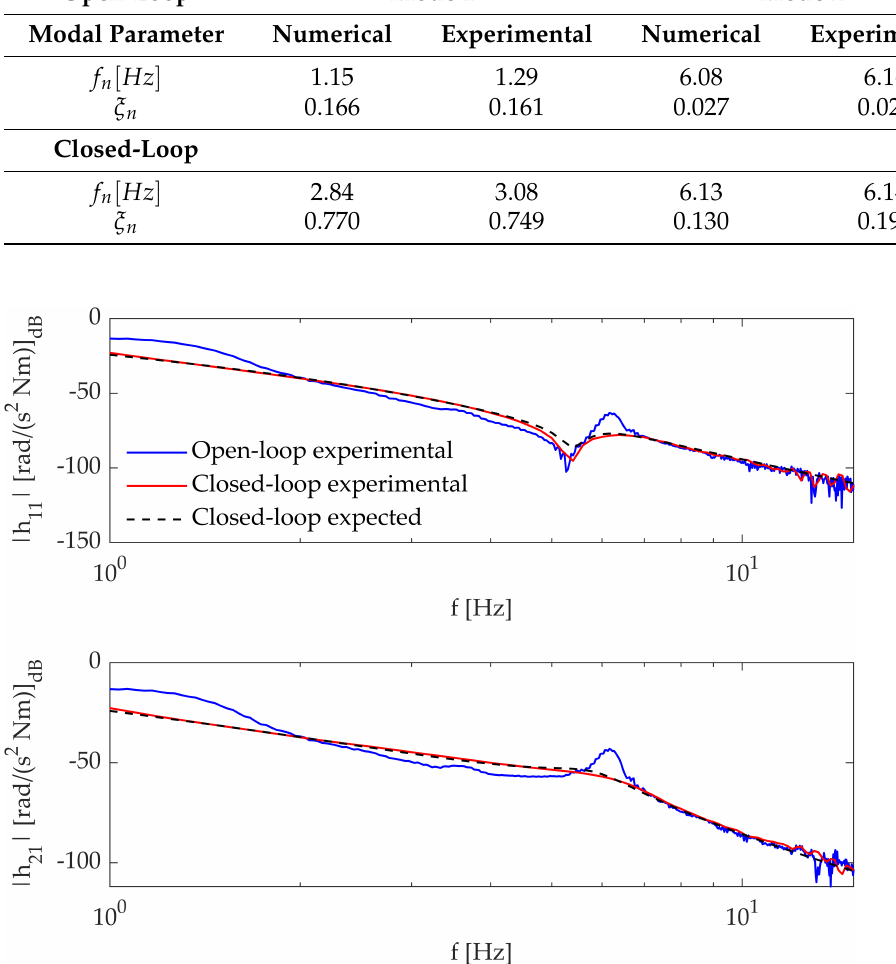
Figure 8. Test case 1: expected and experimental